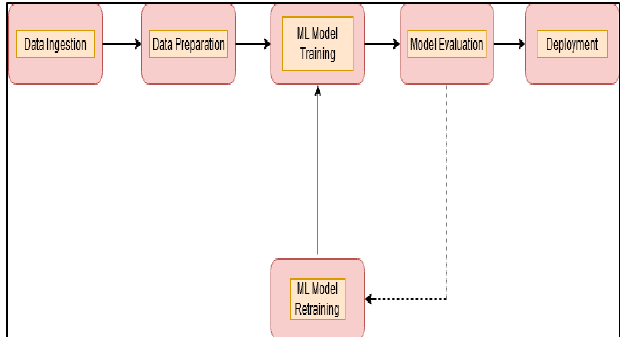
Figure 1: System